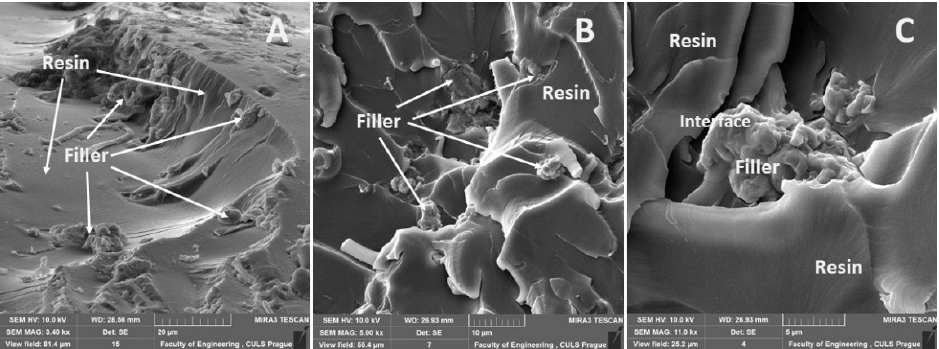
Figure 9. SEM micrographs—static tensile test of composite materials: ( A ) fracture surface of adhesive E53/TFF/100:22/CaCO 3 (mag 3.4k×), ( B ) fracture surface of adhesive E53/TFF/100:22/CaCO 3 (mag 5.0k×), ( C ) fracture surface of adhesive E53/TFF/100:22/CaCO 3 with detailed view of filler CaCO 3 (mag